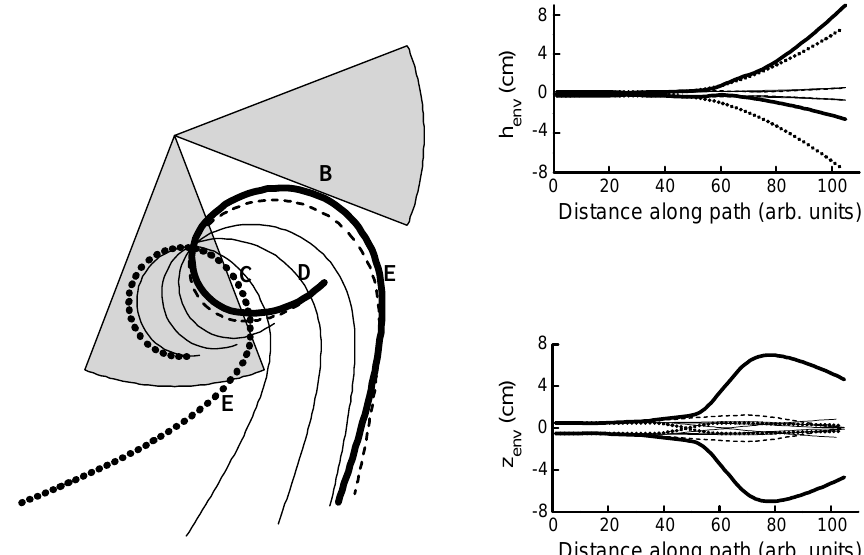
FIG. 5. Influence of different magnetic field gradients on beam envelopes. Extraction of a beam with K (cid:1) 3 is studied. Test ions whose trajectories are shown on the left-hand plot are used as the central ions for corresponding test beams. Initial beam emittances and energy spread are taken to be the same as for Fig. 4. The two graphs on the right show horizontal (upper graph) and axial (lower graph) envelopes of the beam along the beam path. Envelopes are calculated with respect to the central ion in the beam. Influences of sector edge gradients in regions C and B, the pole edge gradient in the E region, and the isochronous increase of the magnetic field in the D region are investigated. Thin solid lines show trajectories and corresponding envelopes of the beams influenced only by the pole edge gradient. This influence is the least pronounced. The joint effect of the gradients in regions D and E is also small, as shown by a thin dashed line. When the weak influence of region E is combined with sector edge influence (region C), the resulting effect is strong, as represented by a dotted line. Finally, a thick solid line is used to show the combined effect of the D, B, and E regions. The dramatic difference in beam envelopes represented by thick solid and dashed lines is caused by sector edge B, while sector edge C is the cause of the difference between the examples depicted by thin solid and dotted lines. When the foil is moved from u f (cid:1) 90 ± in the negative